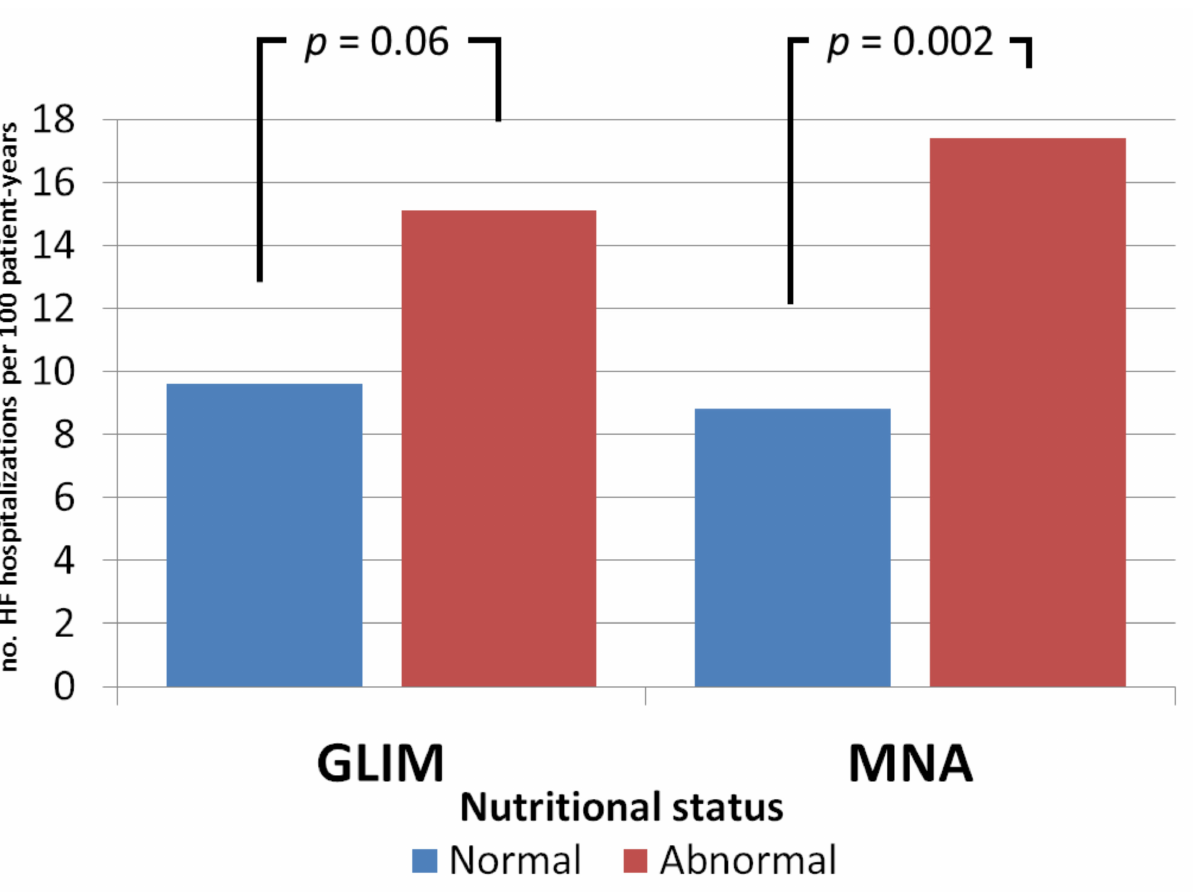
Figure 3. Crude incidence (per 100 patient-years) of recurrent heart failure-related hospitalizations relative to the nutritional